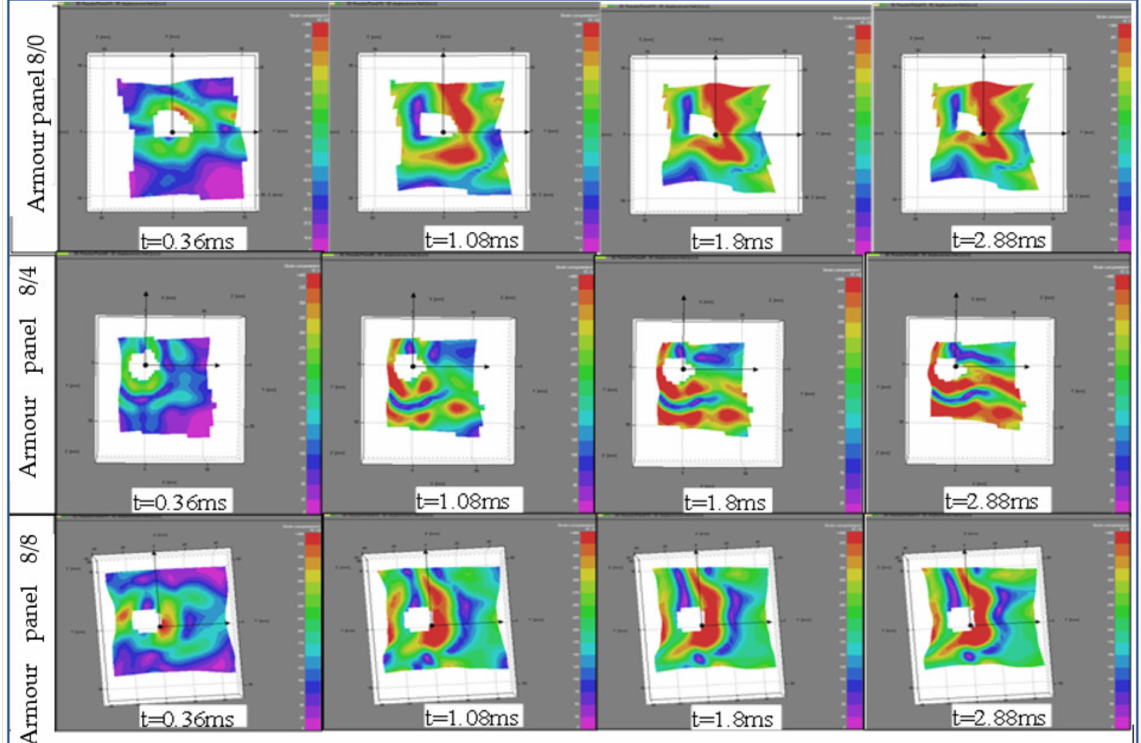
Figure 11. Image sequences of an impacted panel at front with selected time at shot point